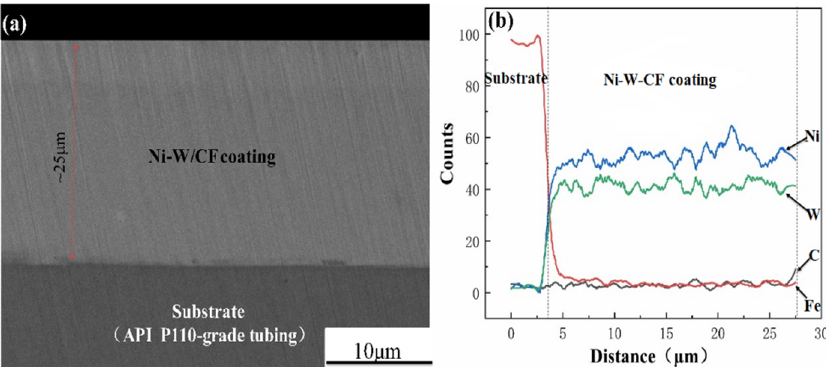
Figure 2. The cross-section ( a ) and line-scan pattern ( b ) of Ni-W-CF composite coating prepared when CF content is 0.4g/L.